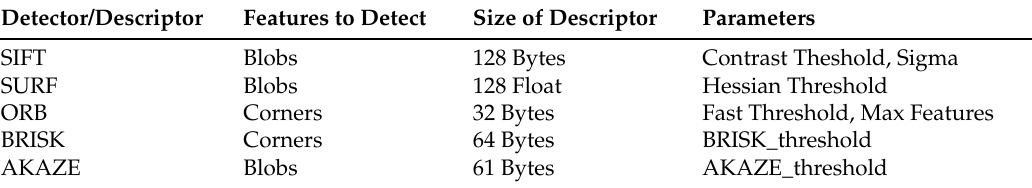
Table 1. Detectors/Descriptors characteristics and